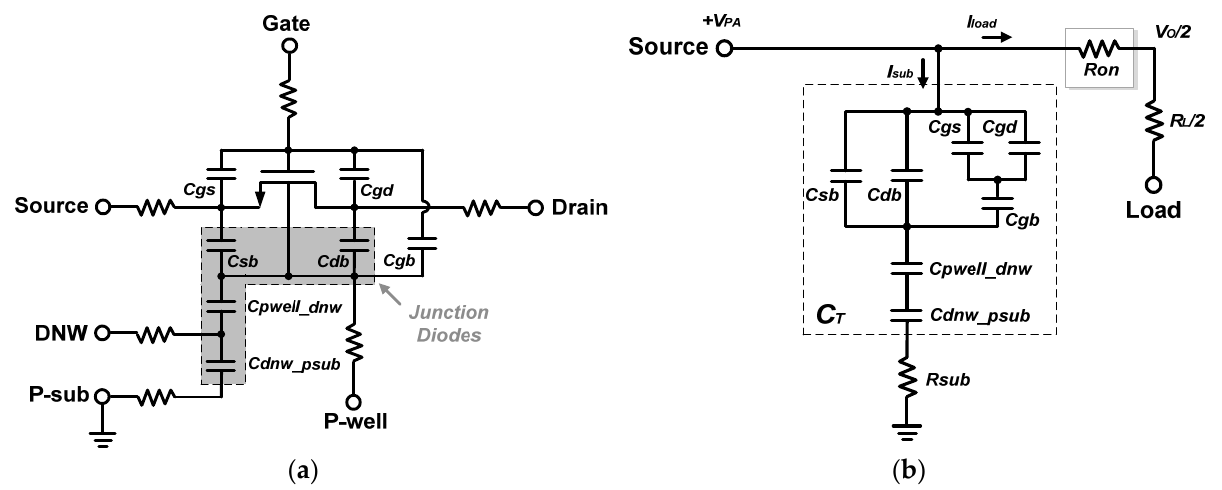
Figure 8. ( a ) Equivalent circuit model of deep n-well switch devices including substrate junction diodes. ( b ) Simplified equivalent circuit model for analysis.